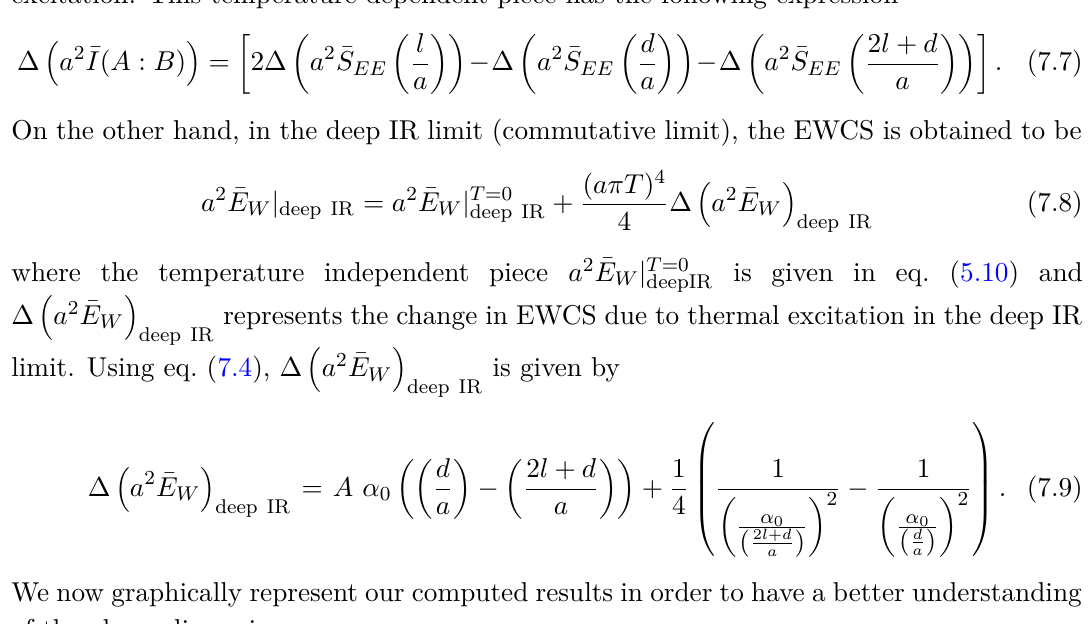
Figure 8 . Effect of noncommutativity on EWCS and HMI at finite temperature with aT = 0 . 1 (red) and aT = 0 . 2 (blue) (we have set l = 6 ) is shown in the left panel. The curve depict the π a analytical results. The value of au b = 10 for which eq. (6.25) gives l c l c = 5 . 00232 for aT = 0 . 2 . The right panel depict the corresponding results in the deep IR a π